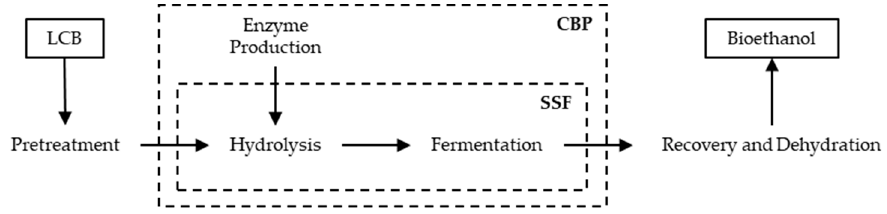
Figure 3. Possible configurations of the process for bioethanol production from LCB.